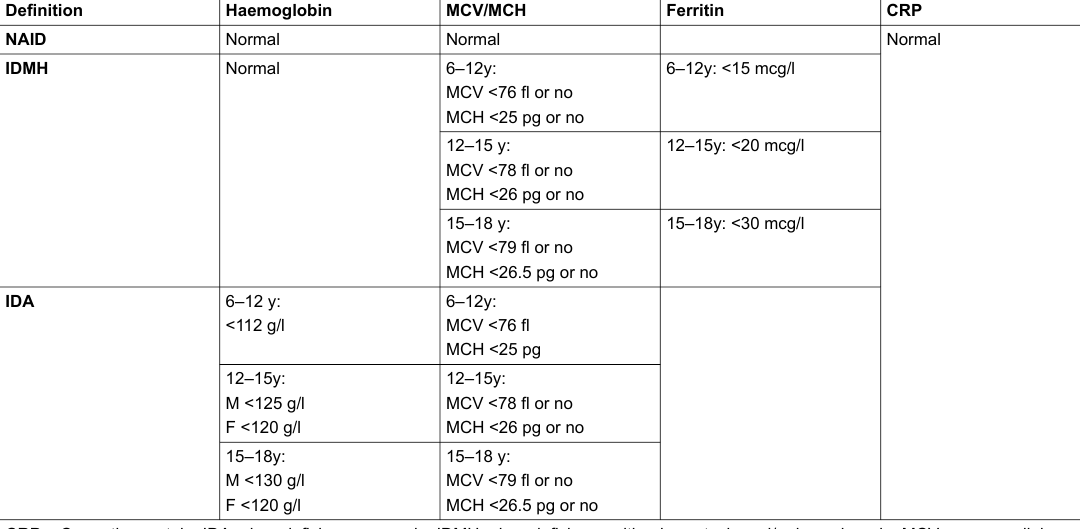
Table 3: Critical cut-offs for differentiation of iron deficiency in children and adolescents. Adapted from Herklotz et al. [29].